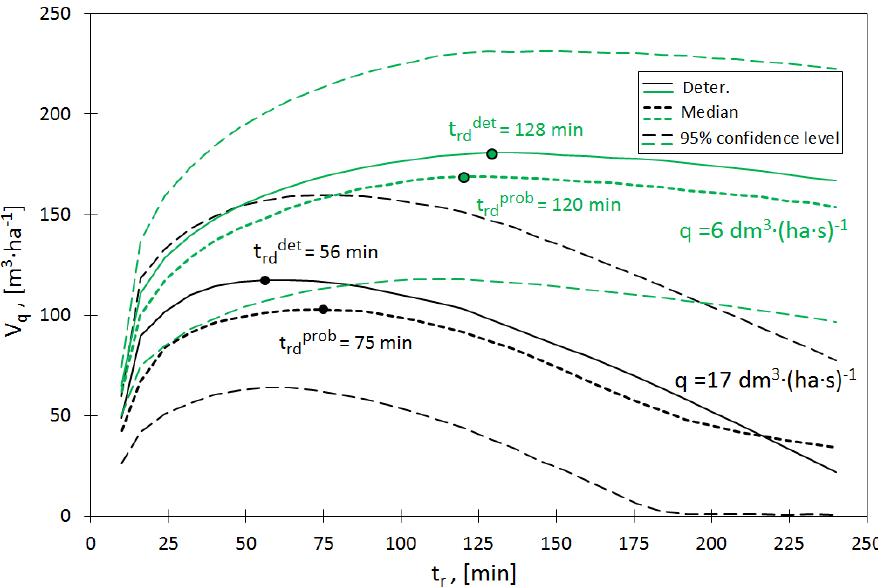
Figure 5. Influence of the unit outflow from the reservoir ( q ) and the time duration rainfall ( t r ) on the unit accumulation capacity ( V q ), taking into account the model uncertainty.